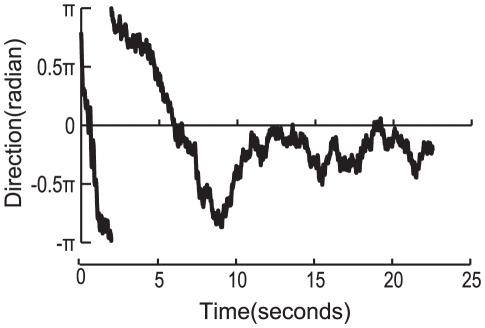
Temporal patterns of a honeybee's localization toward two sound sources.The time traces of a honeybee's orientation in response to flight and dance sounds are shown. Each loudspeaker (#1, #2, #3, #4) produced flight and dance sounds according to the honeybee's orientation. The time series variation was divided into two phases. The initial phase lasted for up to 10 seconds. During this phase the honeybee did not orient in any particular direction. After 10 seconds, it tended to orient from −0.5π to 0.5π, when the #2 or #3 loudspeakers produced dance sounds.